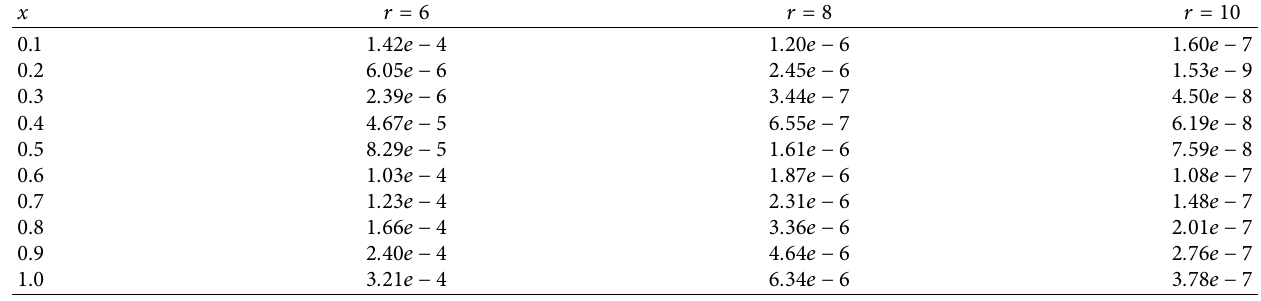
Table 4: The absolute errors at the Chebyshev nodes for Example 3.